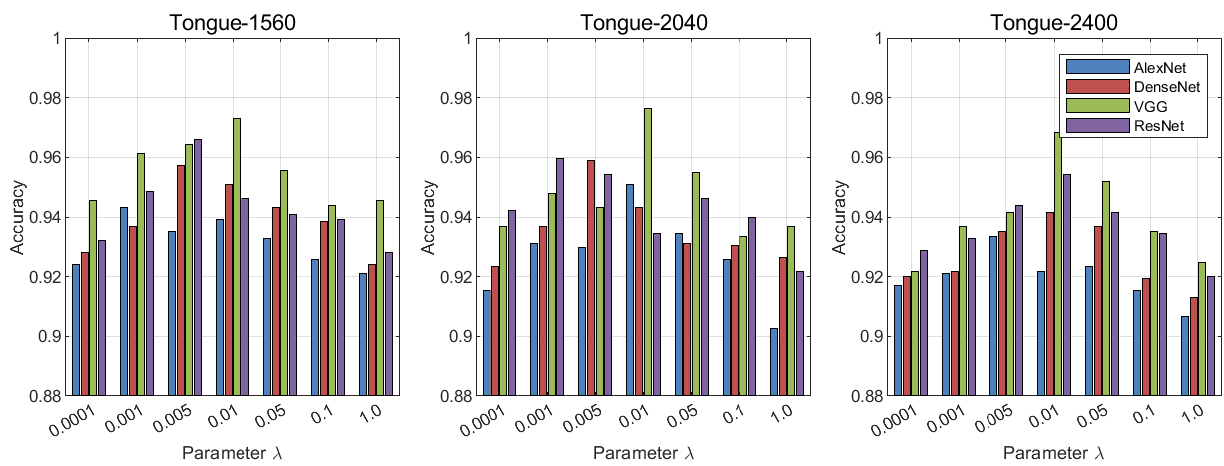
Figure 10. Comparison of mean overall accuracy under different values (SVM classifier).